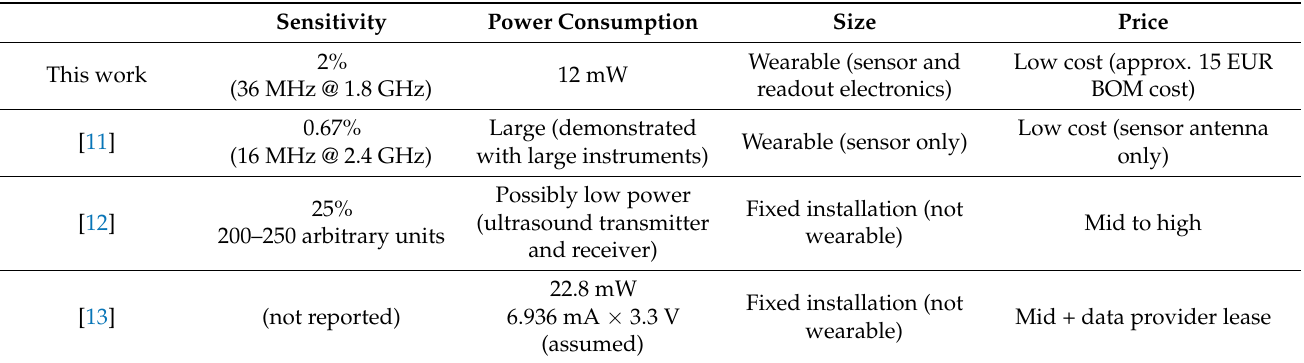
Table 2. Comparison with related